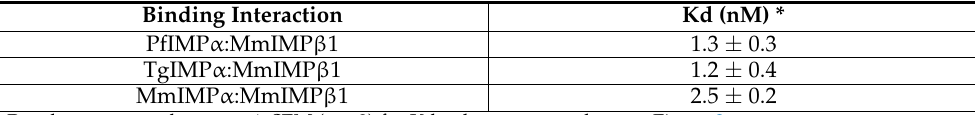
* Results represent the mean ± SEM (n = 3) for Kd values measured as per Figure